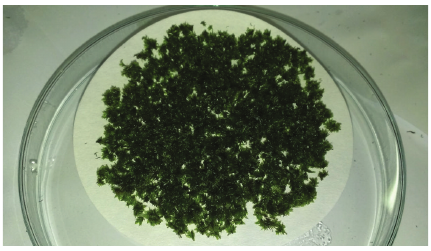
Figure 1: The moss species of Hyophila involuta .